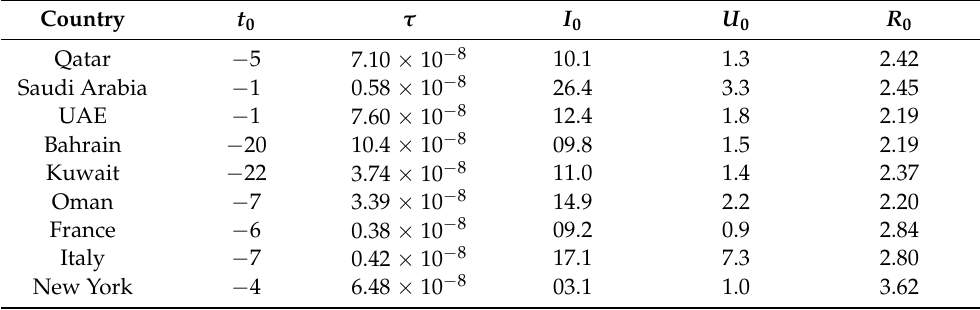
igates the final scale of the epidemic (Figure 6). Table 5. Summary table of t 0 , τ , I 0 , U 0 and R 0 for several countries. For example, t 0 for Qatar is − 5, which means that the estimated starting day of the pandemic is 5 days earlier than the stated day, which means that the estimated starting date of the pandemic is the 24 February 2020. The number of asymptomatic infectious at time t 0 is I 0 = 10.1, and the number of unreported symptomatic infec- tious at time t 0 is U 0 = 1.3. New York city was used for purposes of comparison, since it was the center of the American COVID-19 outbreak.